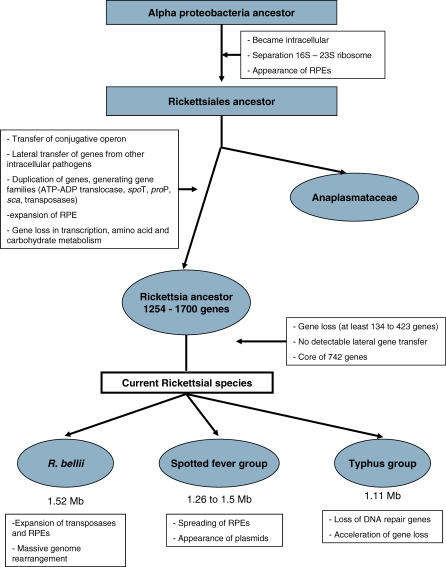
Tentative Scenario Retracing the Evolution of Rickettsia